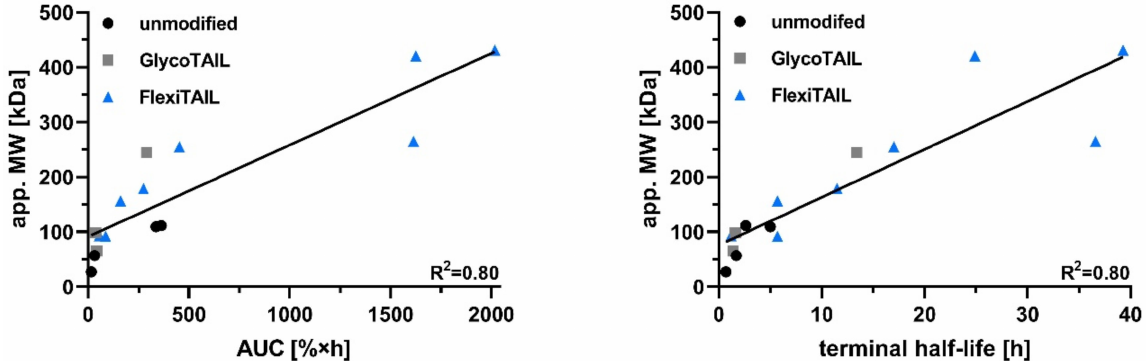
Figure 6. Analysis of the apparent molecular weight and the PK profile. The apparent molecular weight was either analyzed against the mean of terminal half-life [h] or against the mean of the drug exposure (AUC [% × h]) of the different molecules. A linear fit was included in the graphs. R 2 describes the goodness of the